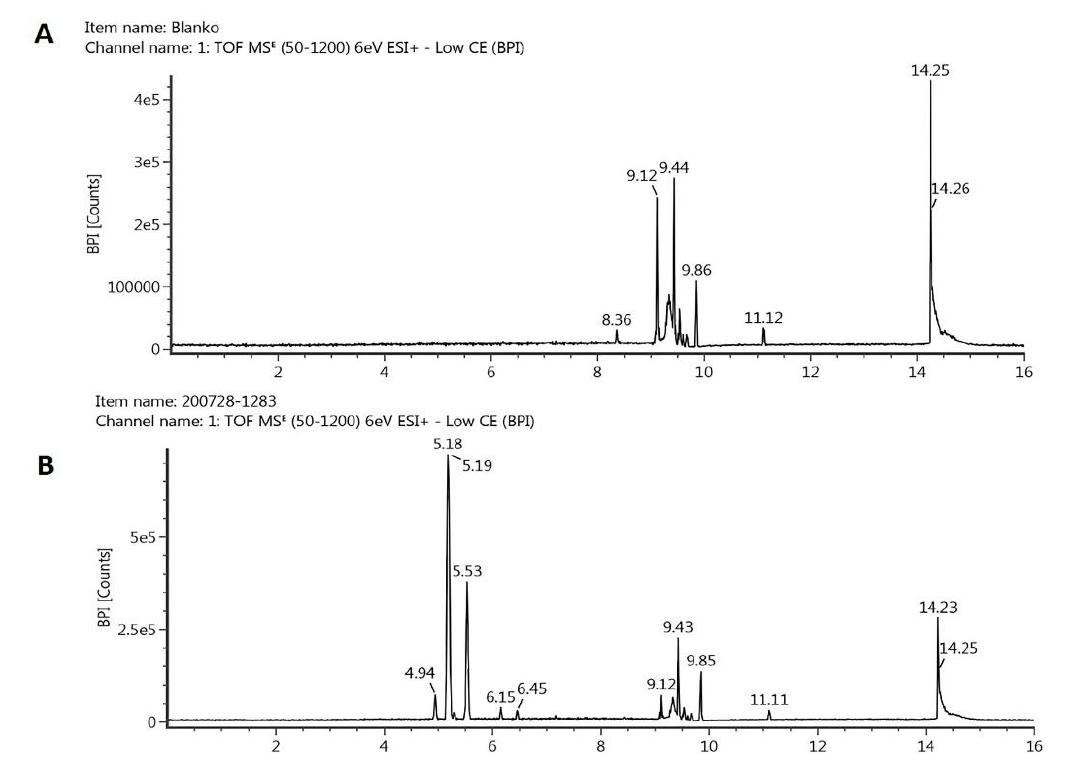
Figure 3. Chromatogram of blank (A) and F4.7 GMY01 (B) using LCMS/MS